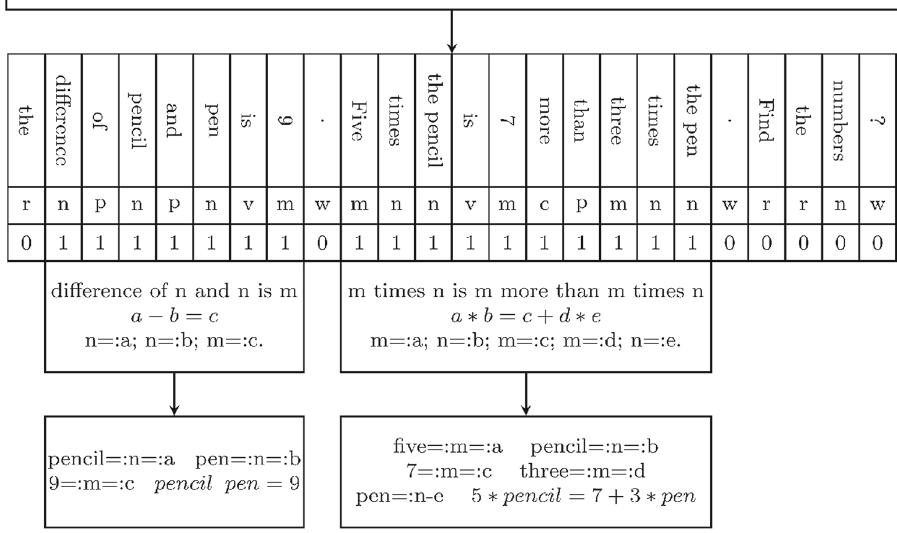
Fig. 3 The process of using S 2 method to extract explicit relations from a sample